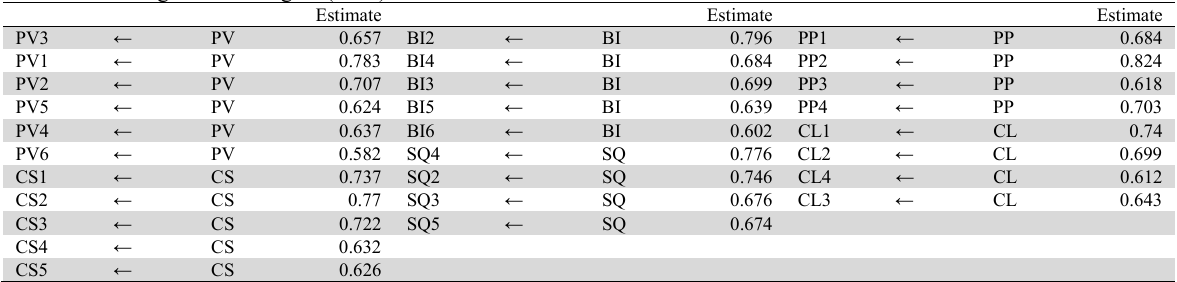
Standardized Regression Weights (CFA)